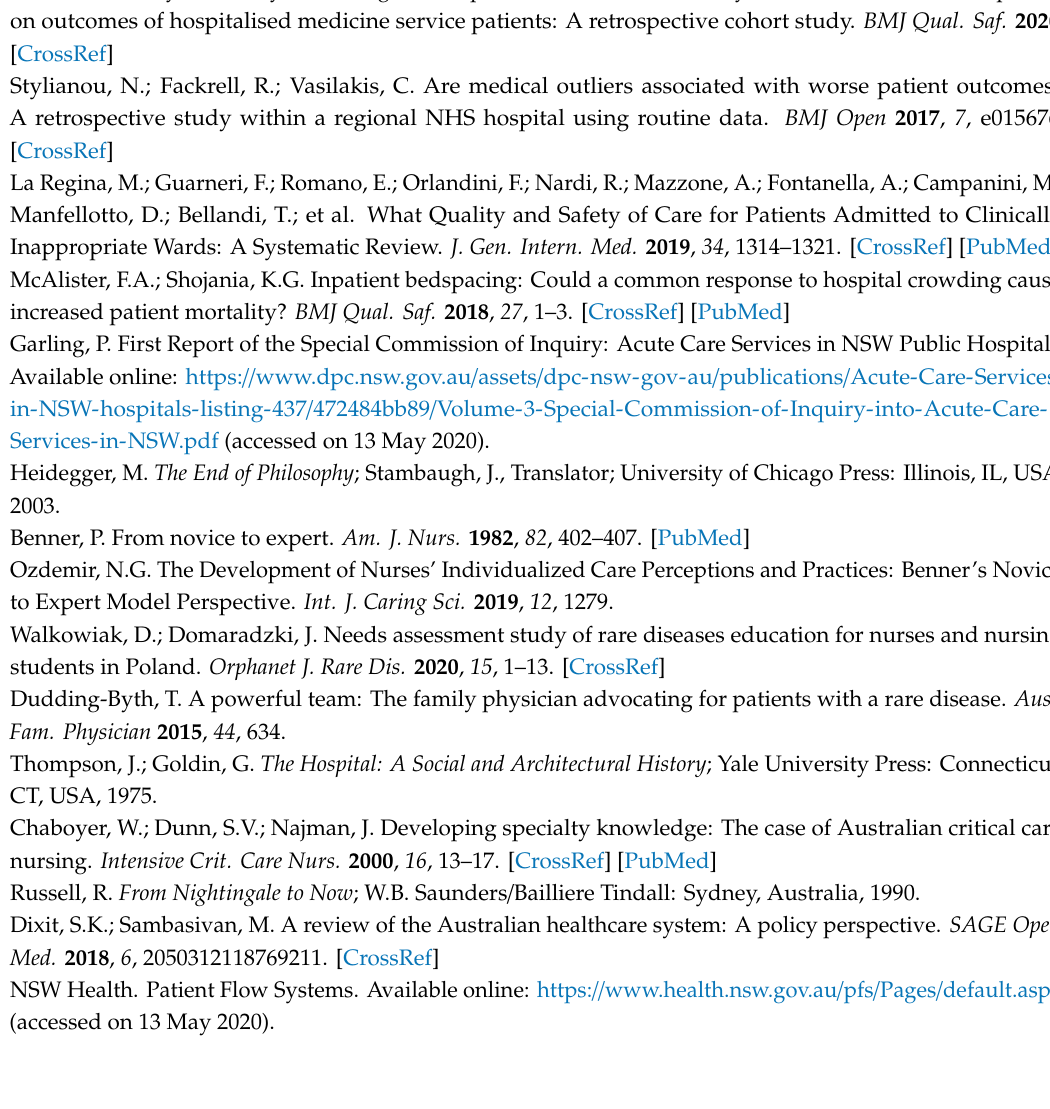
Table S1: COREQ (COnsolidated criteria for REporting Qualitative research)